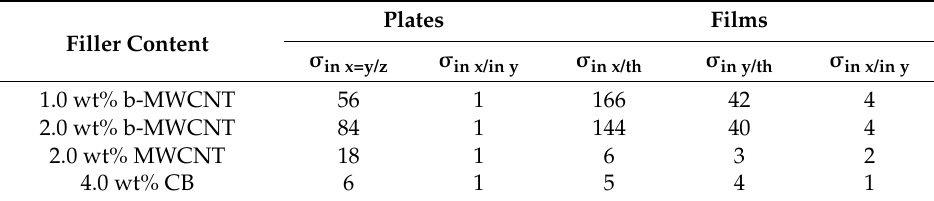
Table 5. Comparison of the σ quotients of electrical conductivities measured in two and three directions for plates and films.